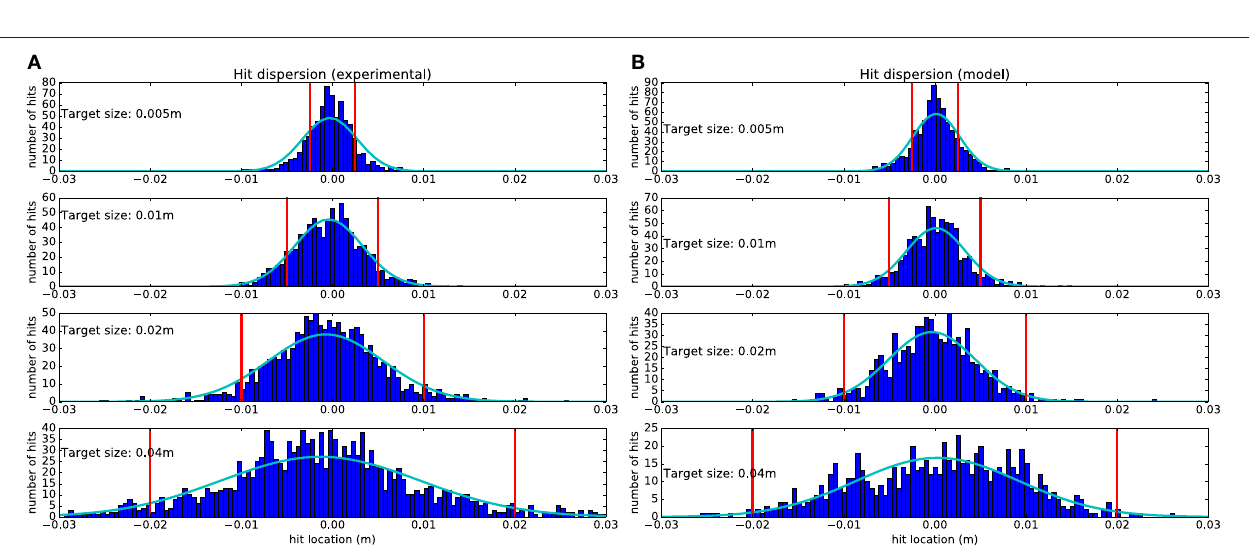
FIGURE 3 | Fitts’ law. (A) obtained from all subjects trajectories. (B) obtained from the model. Each dot corresponds to an average for each target size and target distance pair, obtained either over all subjects or over 1,500 model trajectories.